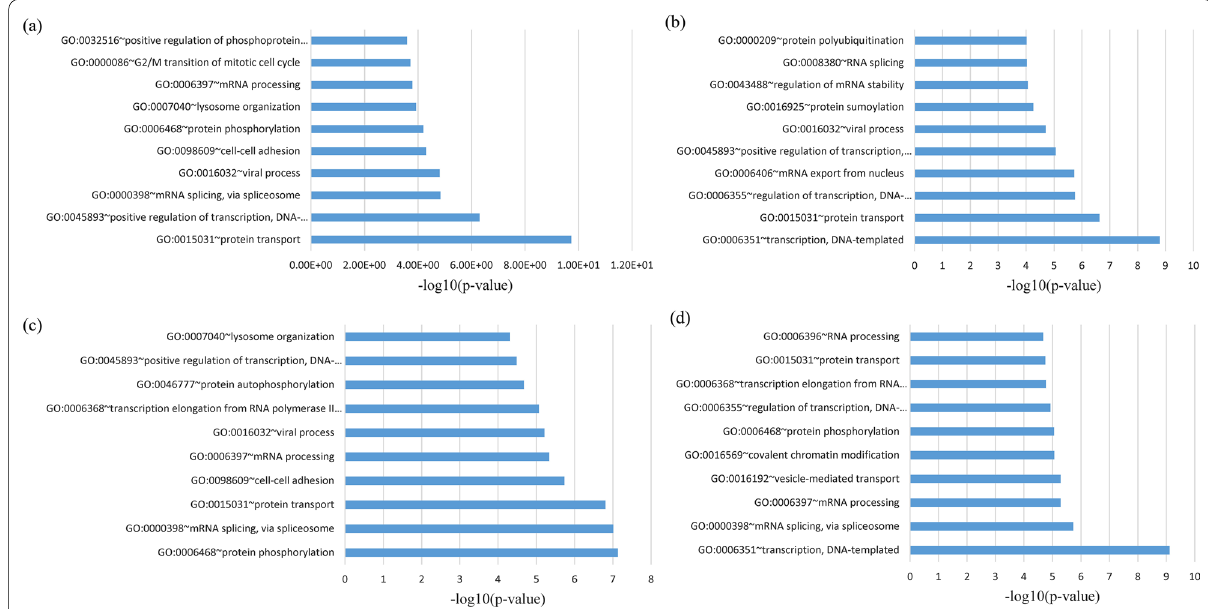
Fig. 1 GO biological process enrichment analysis of overlapping DEGs: a mild COVID-19 versus CHB, b mild COVID-19 versus HCC, c severe COVID-19 versus CHB, d severe COVID-19 versus HCC